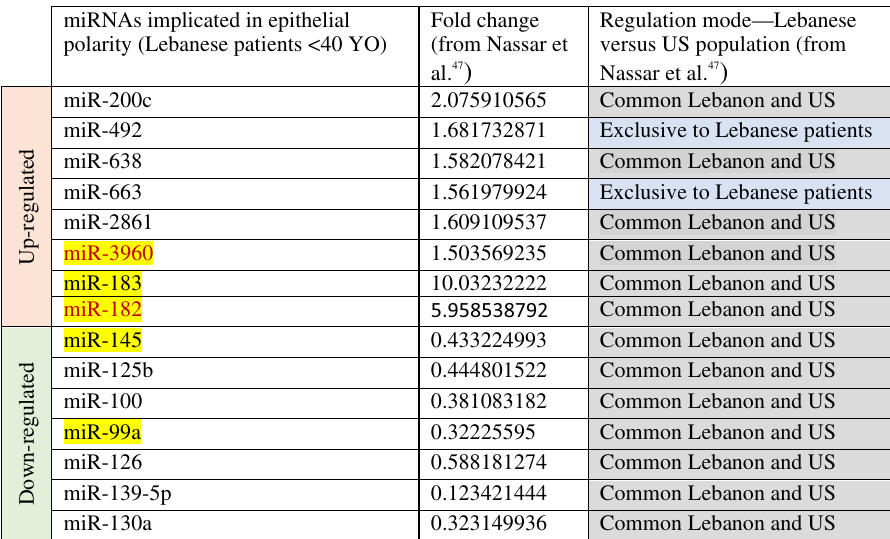
Table 2. Literature search of tumor-associated miRNAs from microarrays of early-stage Lebanese breast cancer patients 47 uncovered fifteen miRNAs involved in epithelial polarity and cancer pathways. Building on Nassar et al. 47 , 74 miRNAs were differentially expressed in Lebanese patients with early-stage breast cancer with no distant metastasis, of which 42.2% were below the age of 40. We identified through a comprehensive literature review 15 patient tumor-associated miRNAs that are involved in early events of breast tumorigenesis and affect epithelial polarity 49,61–64 . Eight of these miRNAs are up-regulated and seven are down-regulated in breast cancer tissues as compared to normal adjacent tissues. Orange highlight panel refers to up-regulated miRNAs, green highlight panel represents down-regulated miRNAs, blue highlights refer to miRNAs exclusively dysregulated in the Lebanese population, while miRNAs highlighted in grey refer to miRNAs commonly dysregulated in both Lebanese and matched US patients (stage, histology and metastasis statuses) as reported in Nassar et al. 47 . miRNAs highlighted in yellow are in common between early-stage patient miRNAs involved in epithelial polarity and MREs predicted to be sponged by the selected significant circRNAs (as shown in Tables 1 and 3). Only miRNAs highlighted in both yellow highlight and red font are implicated in epithelial polarity from patients miRNome and are in common with MREs predicted to be sponged by the RT-qPCR validated significant circRNAs. Thus, these were selected for investigation in the potential post-transcriptional signature axes in the scope of this